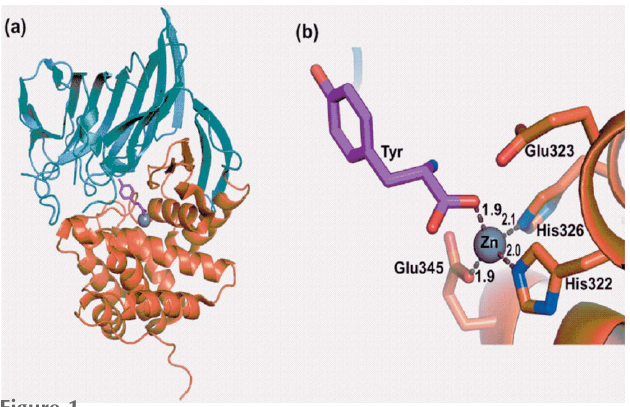
Figure 1 ( a ) Crystal structure of M1dr at 77 K. ( b ) Zn-binding sub-unit of